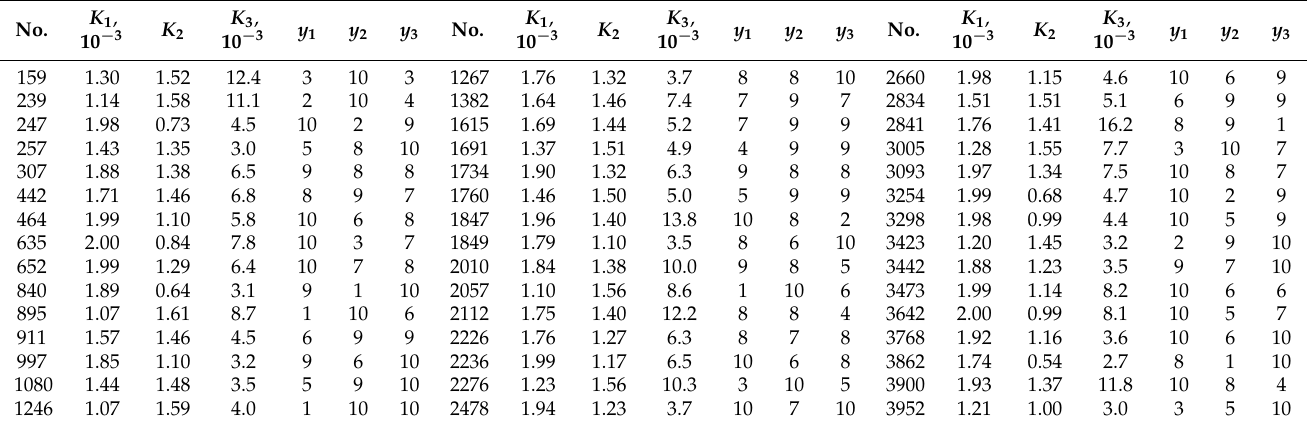
Table 2. The values of the initial criteria and the obtained vector scores y = ( y 1 , y 2 , y 3 ) for 45 options. K 1 , No. 10 −